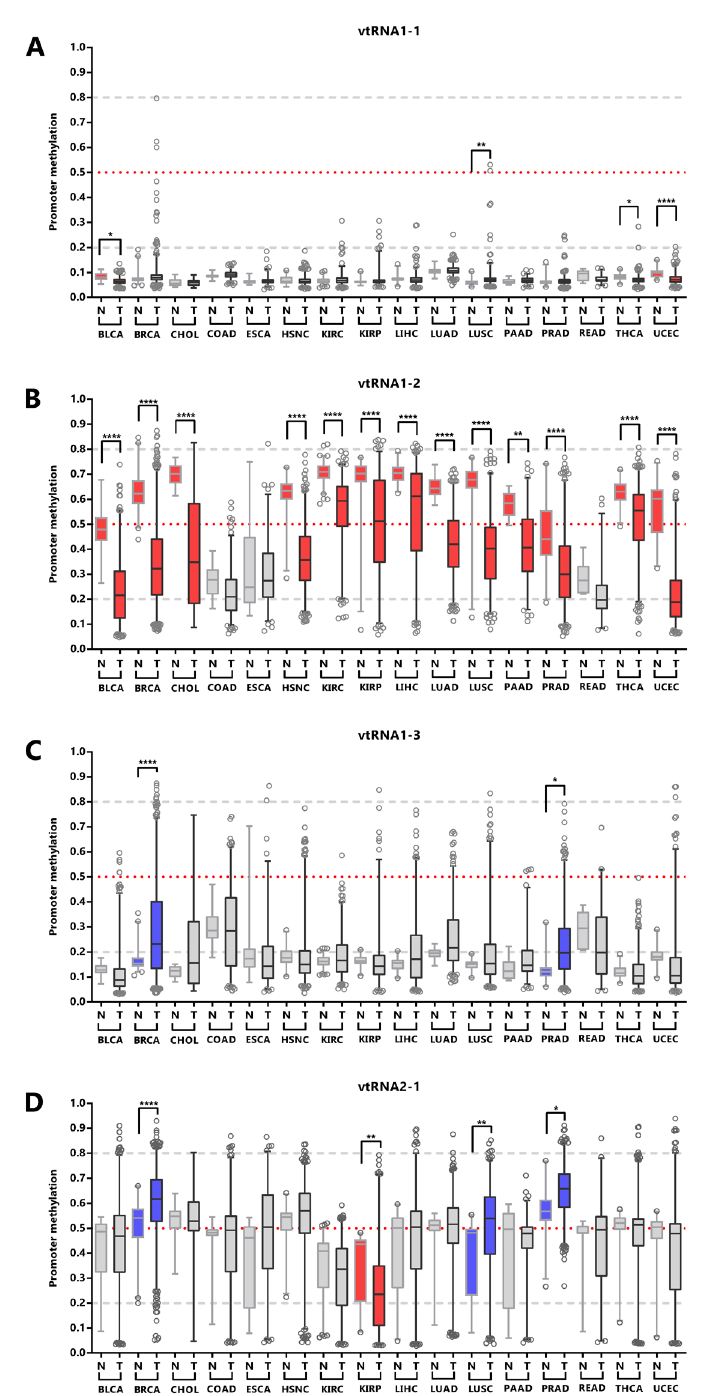
Figure 6. VtRNA promoters DNA methylation in Normal vs. Tumor samples. Average beta-values of promoter DNA methylation for vtRNA1-1 ( A ) vtRNA1-2 ( B ), vtRNA1-3 ( C ) and vtRNA2-1 ( D ). Acronyms indicate the tissue condition (normal (N) and tumor (T)). Blue and red colors indicate an increase or reduction in promoter methylation in tumor vs their normal tissues counterparts. The box plots show the median and the lower and upper quartile, and the whiskers the 2.5 and 97.5 percentile of the distribution. Horizontal, lines denote the methylation level of the promoters: grey striped bottom and top for unmethylated (average beta-value ≤ 0.2) or highly methylated (average beta-value ≥ 0.8) respectively, and red dotted for 50% methylated (average beta-value = 0.5)) promoters. One-way ANOVA multiple test analysis with Sidak as posthoc test was performed. * p-value < 0.05; ** p-value < 0.01; **** p-value <